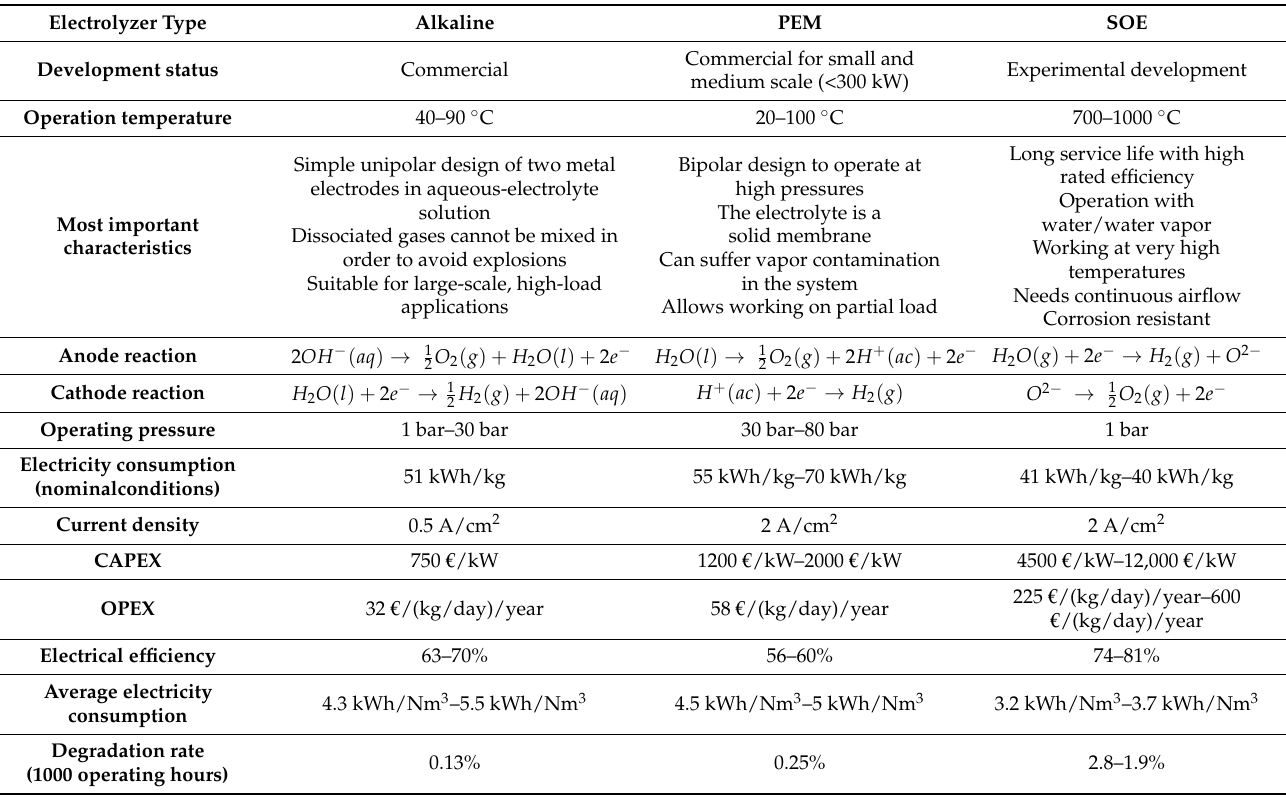
Table A1. The most important characteristics of electrolyzers for Green Hydrogen production in P2G systems, adapted from